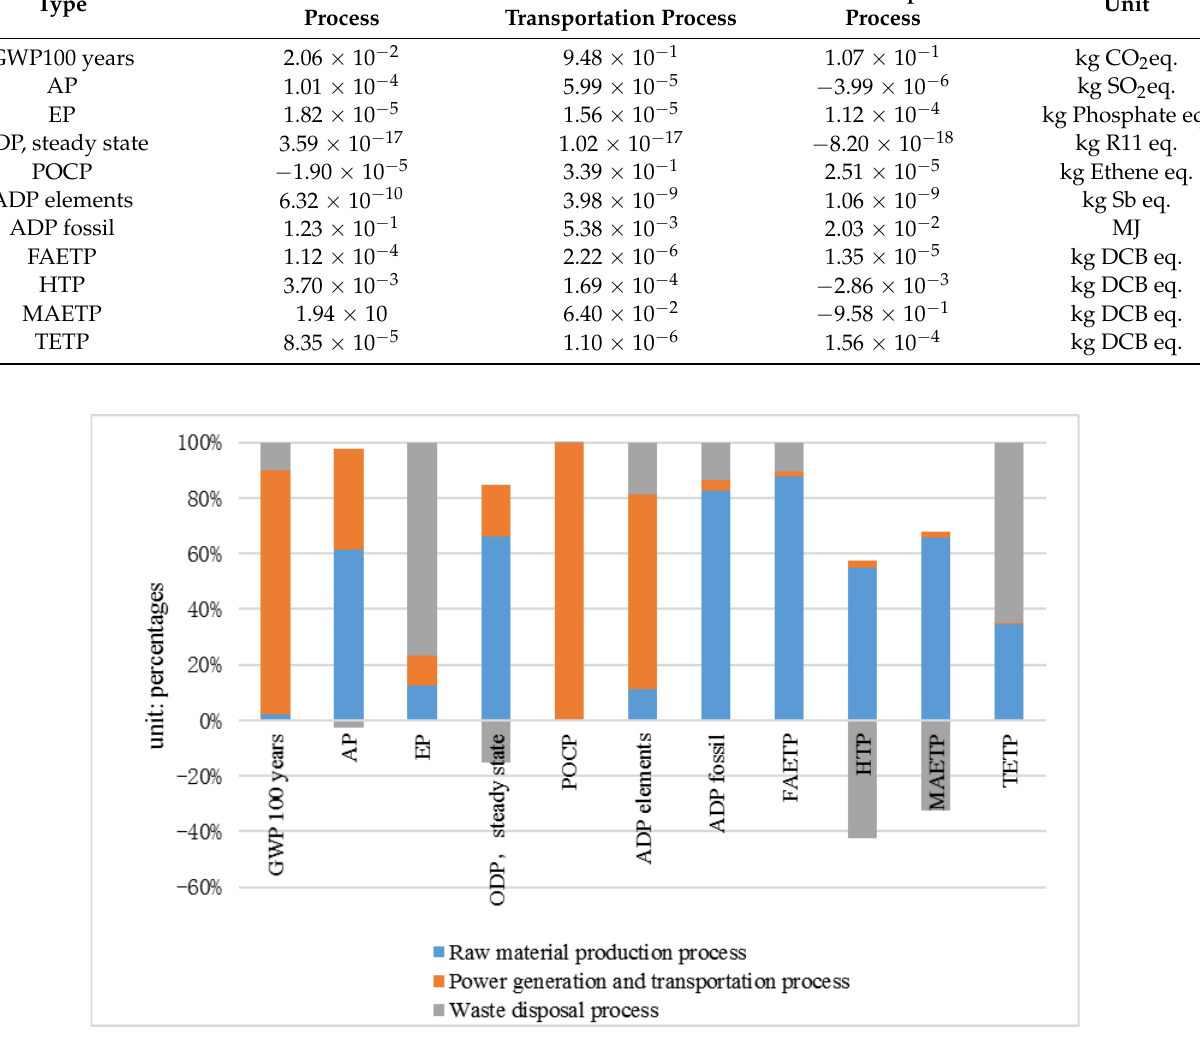
Figure 4. Contribution rate of the environmental impact potential in each process of coal-fired power plants. Table 4. LCA eigenvalue analysis results of coal-fired power plants based on the CML2001 — Jan. 2016 method.